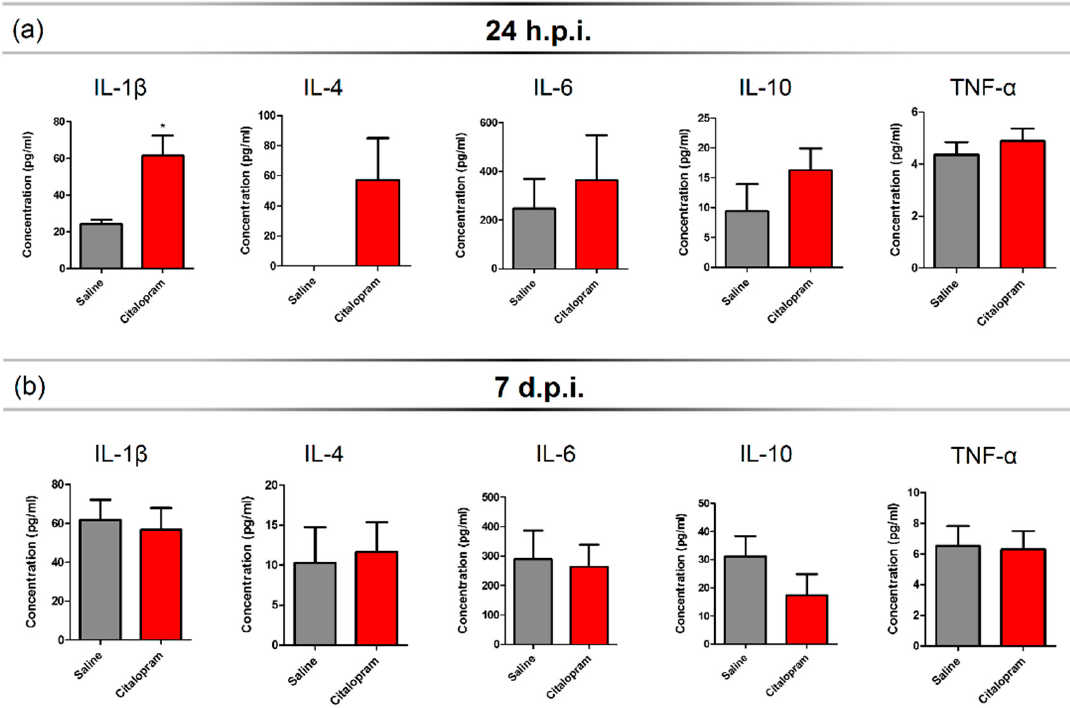
Figure 1. Serum cytokine profile after 7-day citalopram treatment. Levels of IL1 β , IL-4, IL-6, IL-10 and TNF- α were measured in the serum collected at ( a ) 24 h post-injury (hpi) and ( b ) 7 days post-injury (dpi) from animals treated with citalopram ( n = 5) or vehicle ( n = 5). Values shown as mean ± SEM. * p < 0.05.